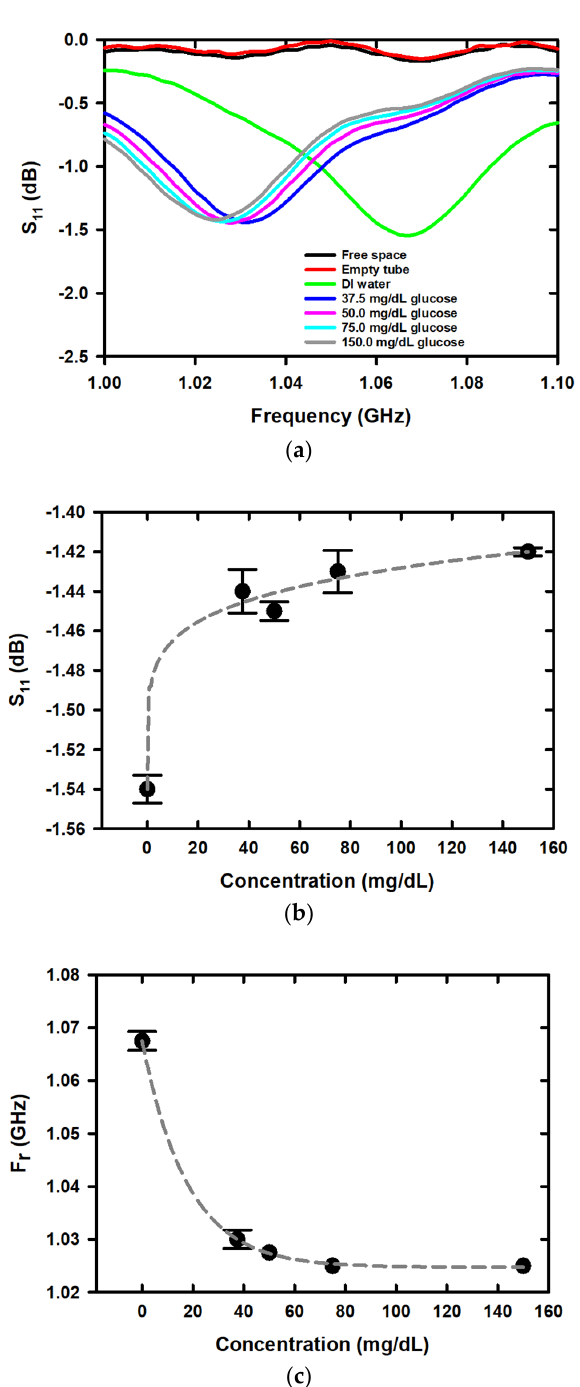
Figure 6. Sensor response signal in peak 1 ( a ) reflection coefficient spectra, and ( b ) S 11 and ( c ) F r of the microwave sensor, as measured by the reflection coefficient for glucose concentrations of 0, 37.5, 50, 75, and 150 mg/dL in the